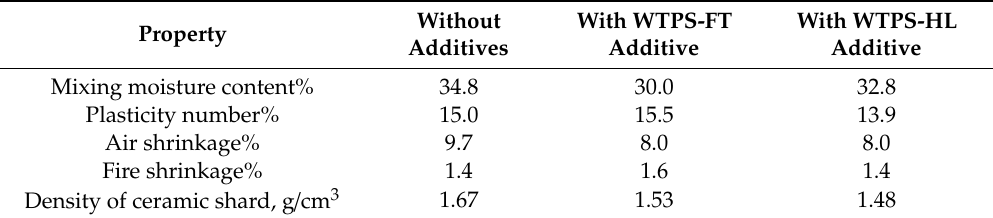
Table 3. Comparison of clay